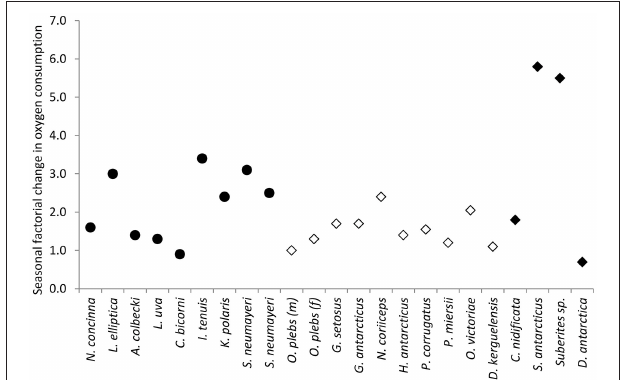
FIGURE 6 | Factorial seasonal changes in oxygen consumption, modified from Obermüller et al. (2010). Filled circles are polar herbivores: Nacella concinna (Fraser et al., 2002a), Laternula elliptic a (Brockington and Peck, 2001), Adamussium colbecki (Heilmayer and Brey, 2003), Liothyrella uva ( Peck et al., 1987, 1997) Camptoplites bicornis, Isoseculiflustra tenuis, Kymella polaris ( Barnes and Peck, 2005), Sterchinus neumayeri - 1997 and 1998 ( Brockington and Peck, 2001). Open diamonds are polar carnivores and scavengers: Orchomene plebs (m, male; f, female) (Rakusa-Suszczewski, 1982), Gammarus setosus (Weslawski and Opalinski, 1997), Glyptonotus antarcticus ( Rakusa-Suszczewski, 1982), Notothenia coriiceps (Campbell et al., 2008 ), Harpagifer antarcticus, Parborlasia corregatus, Paracerodocus miersii, Ophionotus victoriae, and Doris Kerguelensis ( Obermüller et al., 2010). Filled diamonds are sponges from the current